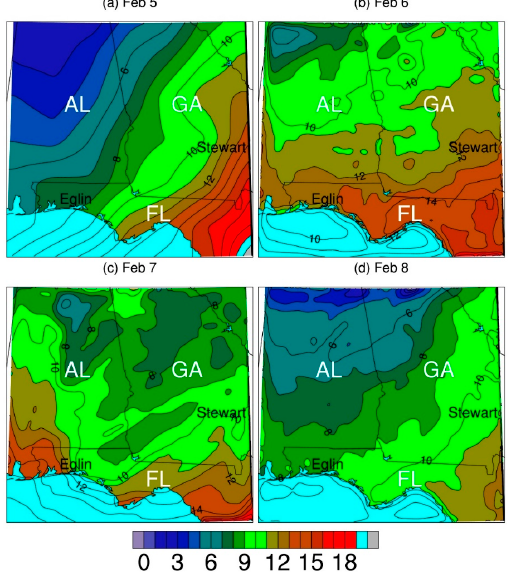
Figure 1. Surface temperature (°C) simulated with WRF. ( a – d ) are 5–8 February 2011 at noon